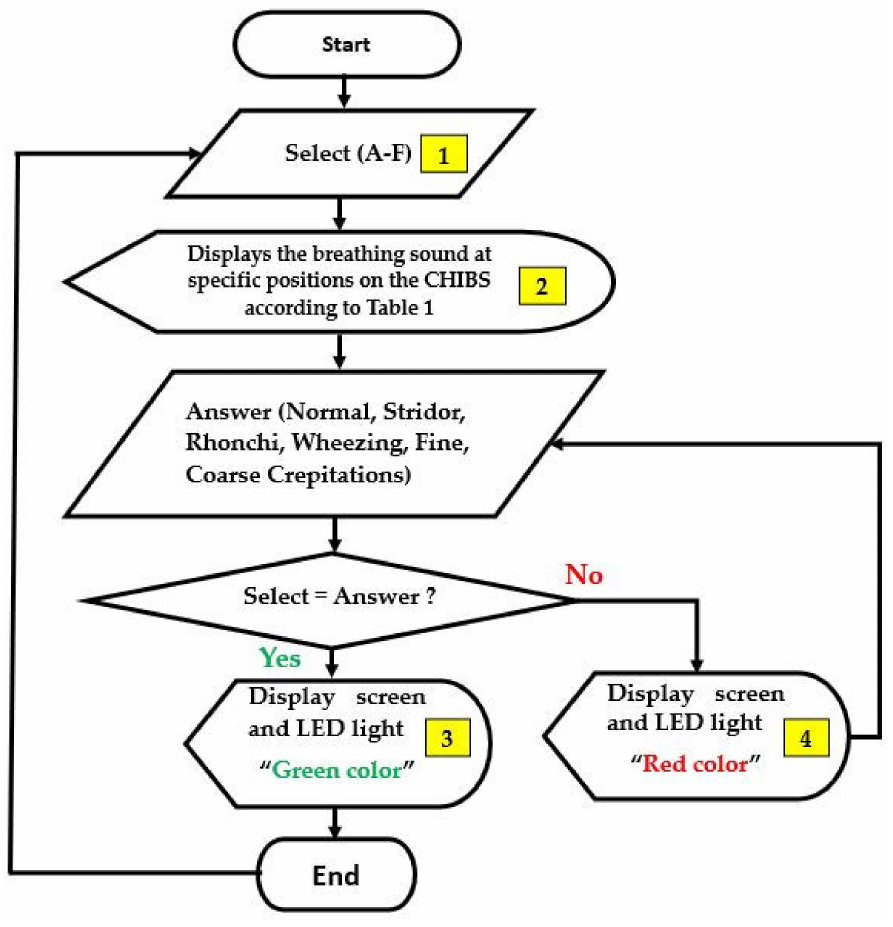
Figure 6. A flowchart describing the